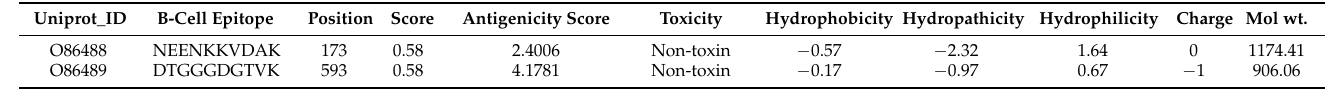
Table 1. Predicted B-cell epitopes from S. aureus Serine–aspartate repeat-containing cell wall adherence proteins, SdrD and SdrE and their corresponding immunogenic